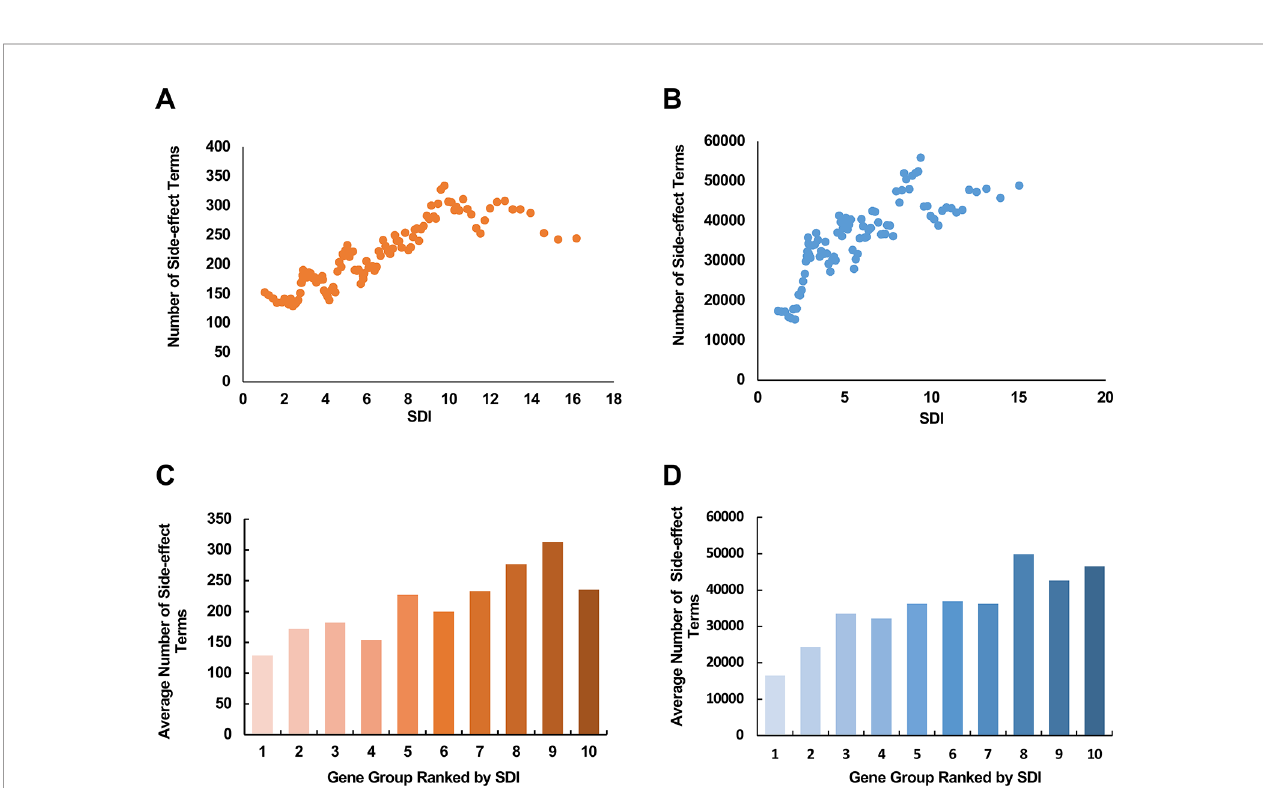
FIGURE 5 | The relationship between SDI and the potential side-effects associated with drug targets. The scatter plots show the correlation between SDI and number of side-effect terms from SIDER database (A) ; VigiAccess (B) of drug targets. The paired scores were smoothed through adequate window and step size. The involved drug target genes were equally divided into ten groups ranked by SDI, and calculated for average numbers of side effect terms from SIDER (C) and VigiAccess (D) . SDI, Subcellular Diversity